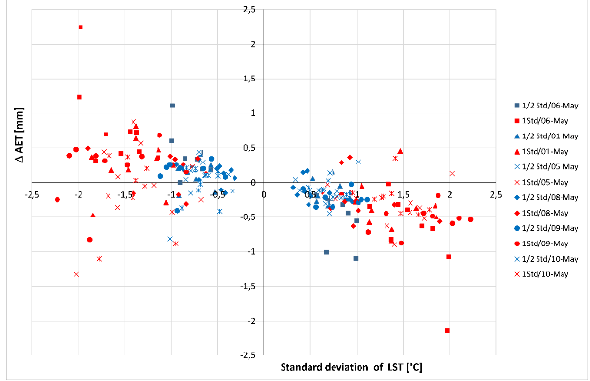
Figure 5. Changes of actual evapotranspiration (AET) against the changes of land surface temperature (LST) input by one-half standard deviation and 1 standard deviation for several selected days within the first decade of May 2010. (Meteorological stations are merged).